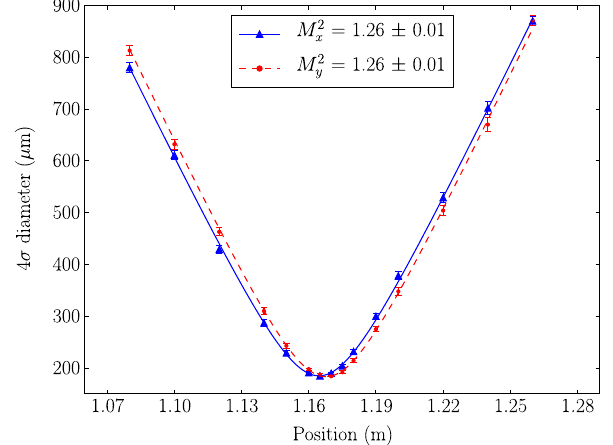
FIG. 8. M 2 measurement of amplified seed pulses with both the x and y fits shown.